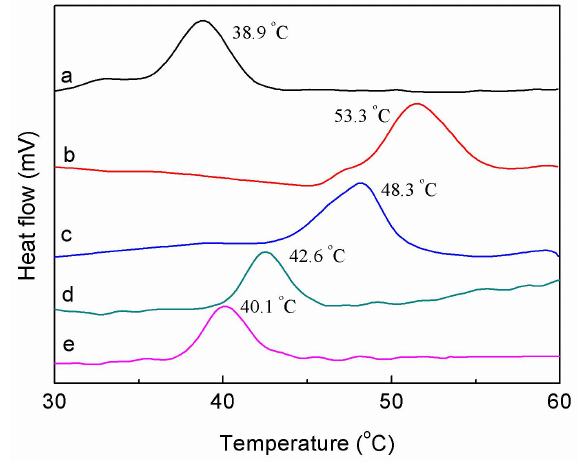
Figure 7. DSC thermograms of native collagen ( a ), and collagen cross-linked by the SiO 2 /DAC hybrid materials: collagen cross-linked by DAC ( b ); collagen cross-linked by SiO 2 /DAC (1/10) ( c ); collagen cross-linked by SiO 2 /DAC (1/2) ( d ); and collagen cross-linked by SiO 2 ( e ).